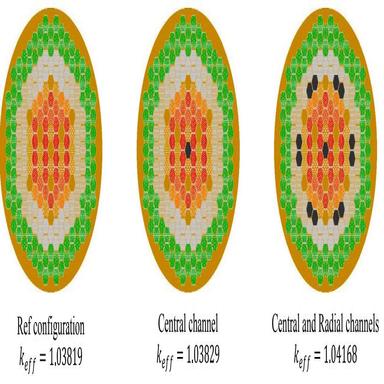
Graphite impact on the reactor neutron economy (statistical uncertainty on keff is less than 30 pcm). Black assemblies represent irradiation targets made of mixture of graphite, helium and stainless steel.